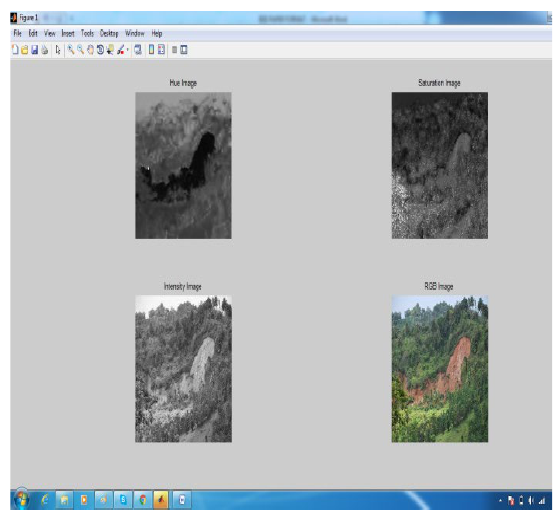
Figure 11. Satellite picture - 1